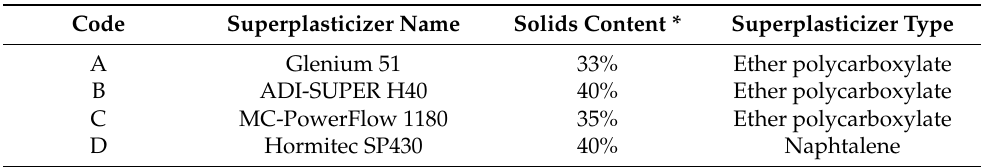
Table 1. Nomenclature used for superplasticizers and their solid content. (* Informed by the manufacturer).